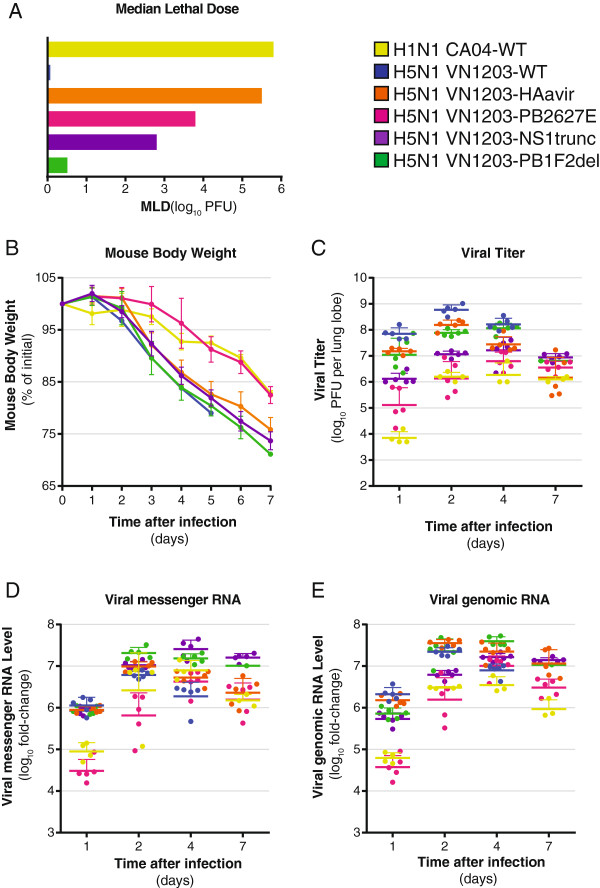
MLD and phenotypical variables collected for all viruses at the 104 PFU infection dosage. (A) Median lethal dose (MLD) values of the different viruses in 6-week-old BALB/c mice. MLD values for VN1203 and mutants were performed in one experiment (3 mice per inoculation dosage), and the previously calculated MLD for CA04 is included for comparison [22]. (B) Mice body weight measurements collected each day from 1 to 7 days post-infection for the 104 PFU infection dosages. For each virus and time point, the mean and the standard deviation of the mice body weight measurements are indicated by a vertical bar. (C), (D) and (E) Viral titer, viral messenger RNA, and viral genomic RNA measurements collected at 1, 2, 4 and 7 days post-infection for the 104 PFU infection dosages. For each virus and time point the set of individual measurements are indicated by filled dots and the mean amongst the individual samples is indicated by a horizontal bar. For the experiments shown in panels B-E, four to five mice were used for all VN1203-WT and pathogenicity mutant infections, while 3–4 mice were used for the CA04 infections. The same animals were used to derive all the phenotypical data (i.e. weight loss, virus titer and virus mRNA/genomic RNA levels).